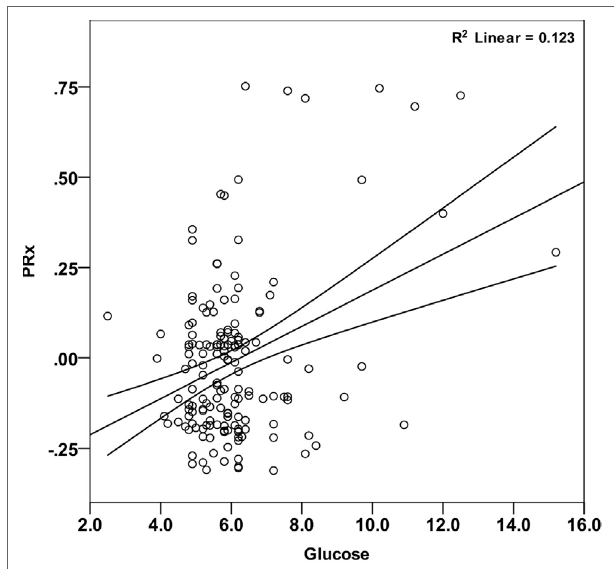
FigUre 2 | Correlation between mean arterial glucose and PRx in pediatric traumatic brain injury patients during the first 5 days since ictus. There was a significant positive relationship between blood glucose and PRx (Pearson correlation = 0.351; p < 0.001). Each data point represents the mean of the available arterial glucose concentration and PRx measurements during the first 5 days since